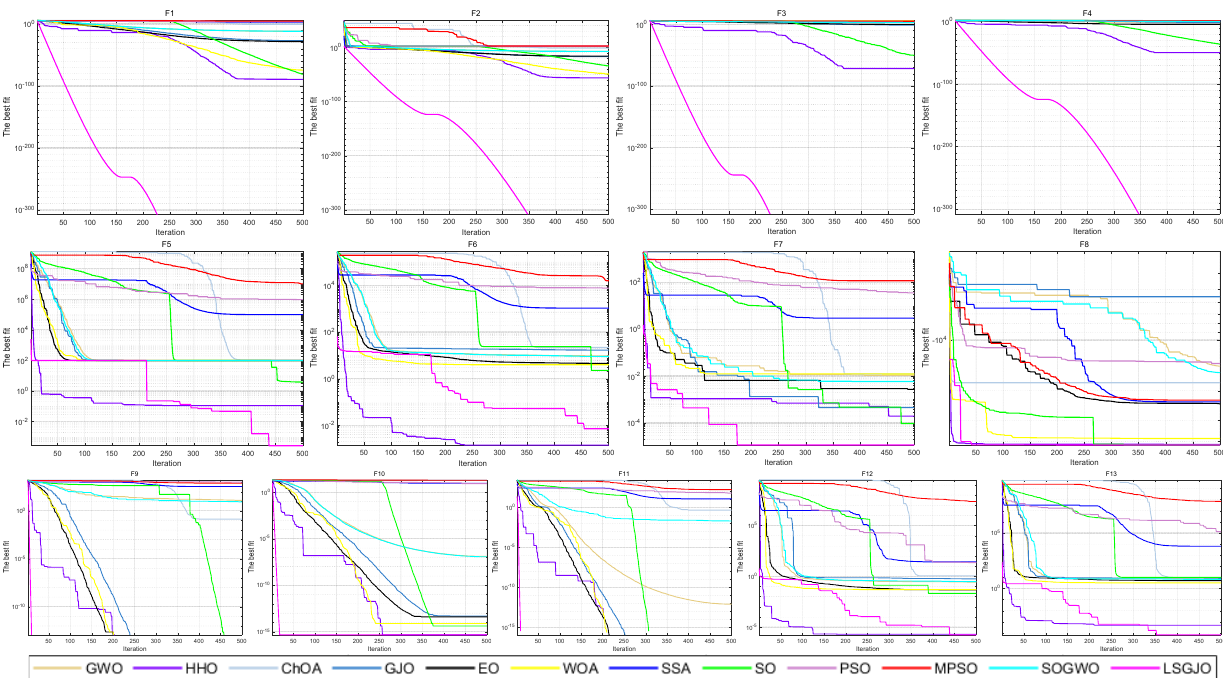
Figure 5. The convergence curves of the LSGJO and other comparison algorithms with Dim = 100.